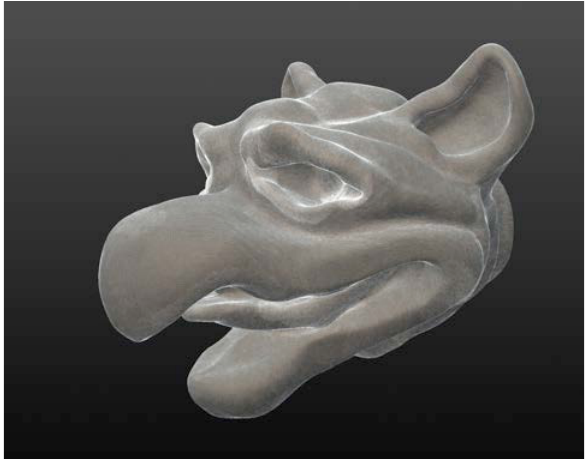
Figure 10. Head produced with modelling software Stone carvers are a group whose working methods are steeped in tradition. The integration of data from close-range laser scanning and photogrammetry into the stone carvers methods was welcomed by the stone carvers to compare or supplement their traditional